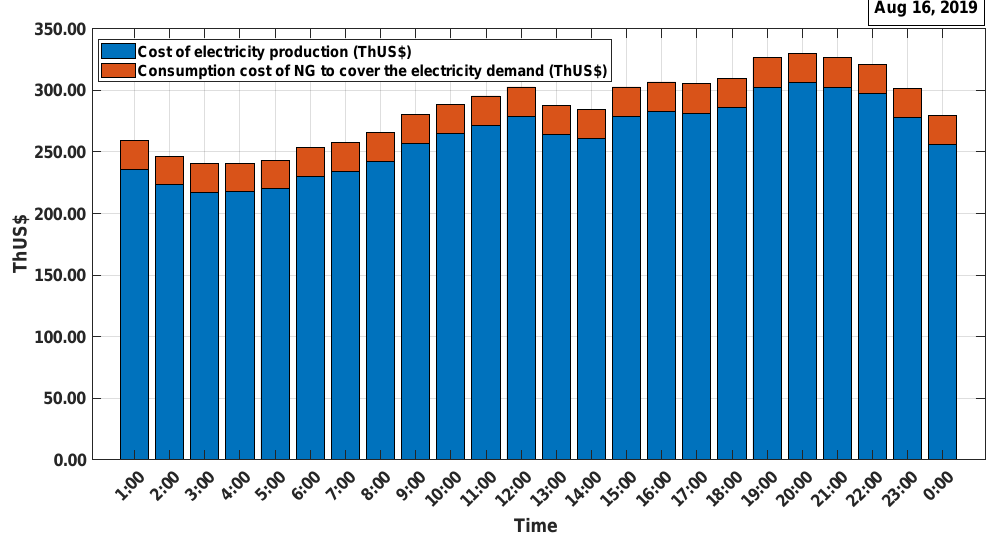
Figure 8. Optimal cost of energy production and ng supply and operation of the integrated gas– electricity system—stage 1.